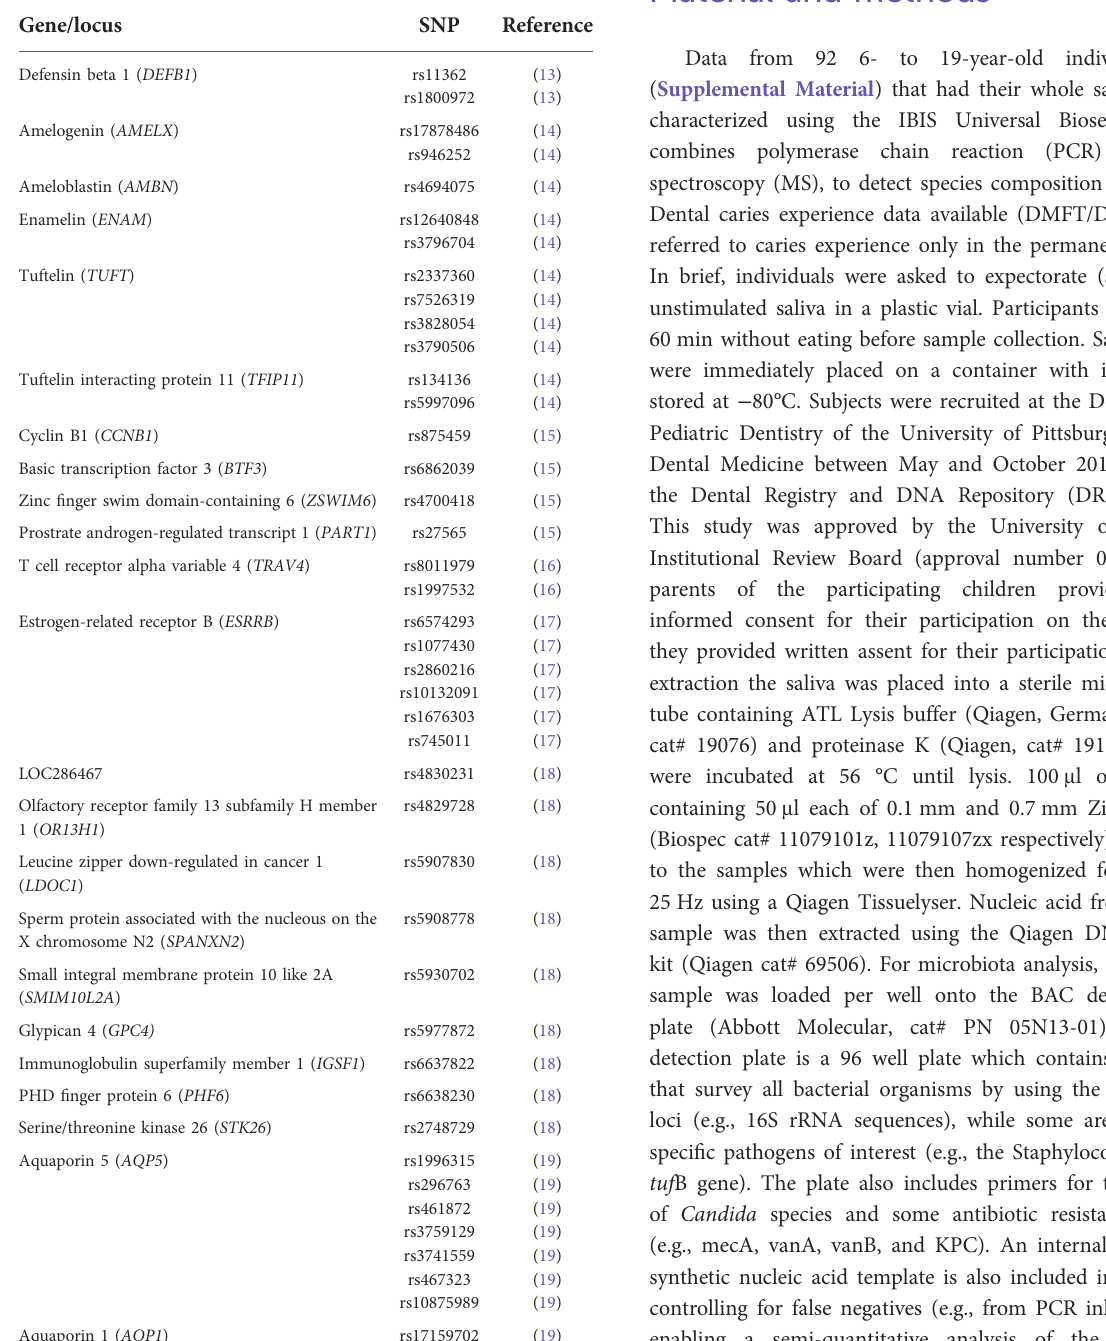
TABLE 1 Single nucleotide polymorphisms (SNPs)